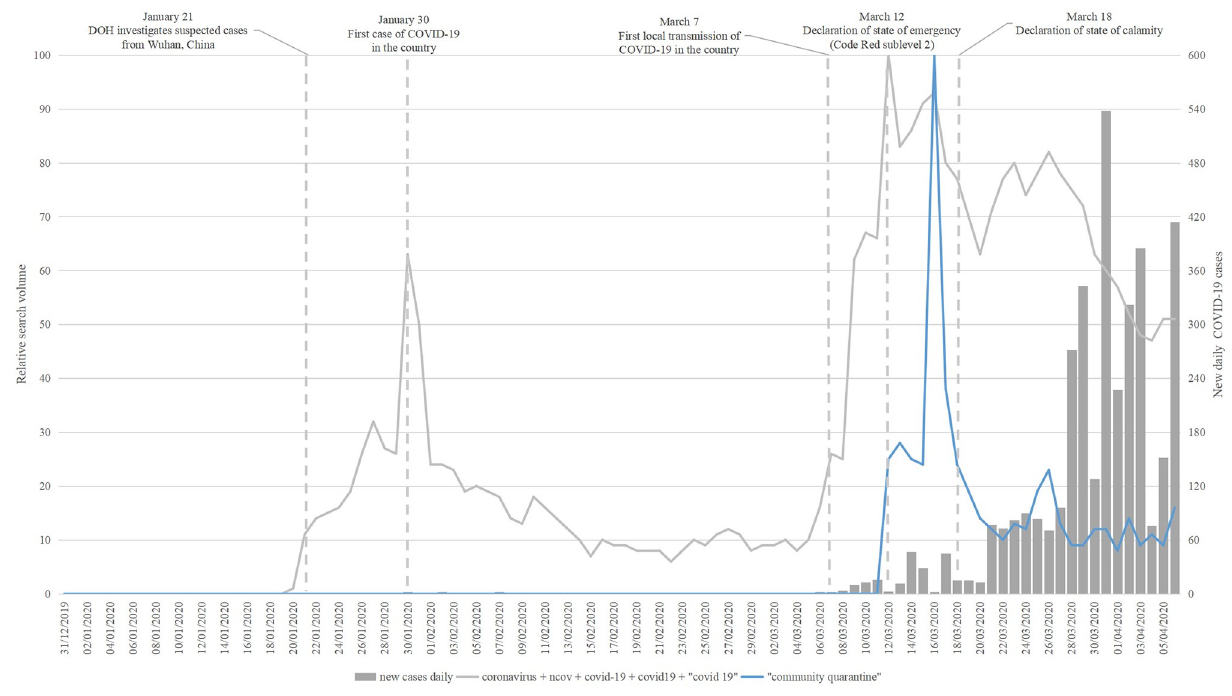
Fig 4. Search interests for community